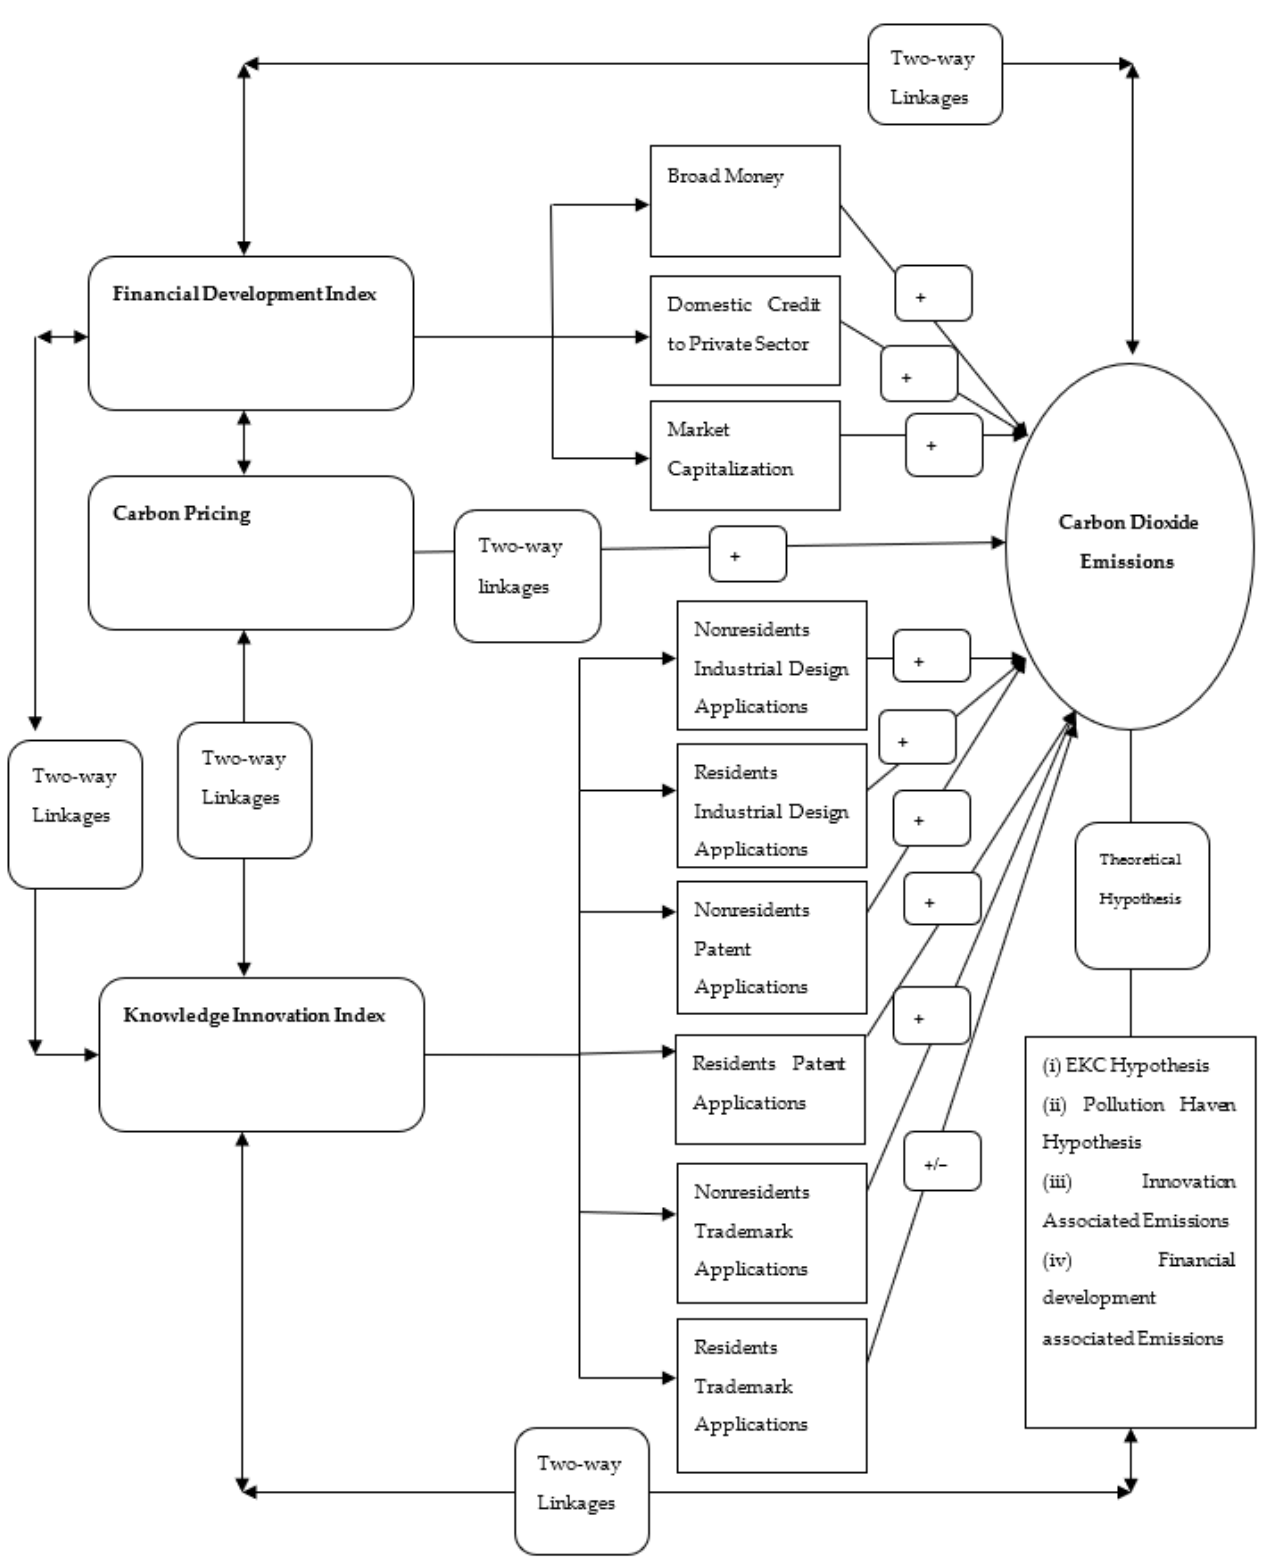
Figure 3. Research Framework of the Study. Source: Author’s extraction from the previous literature.